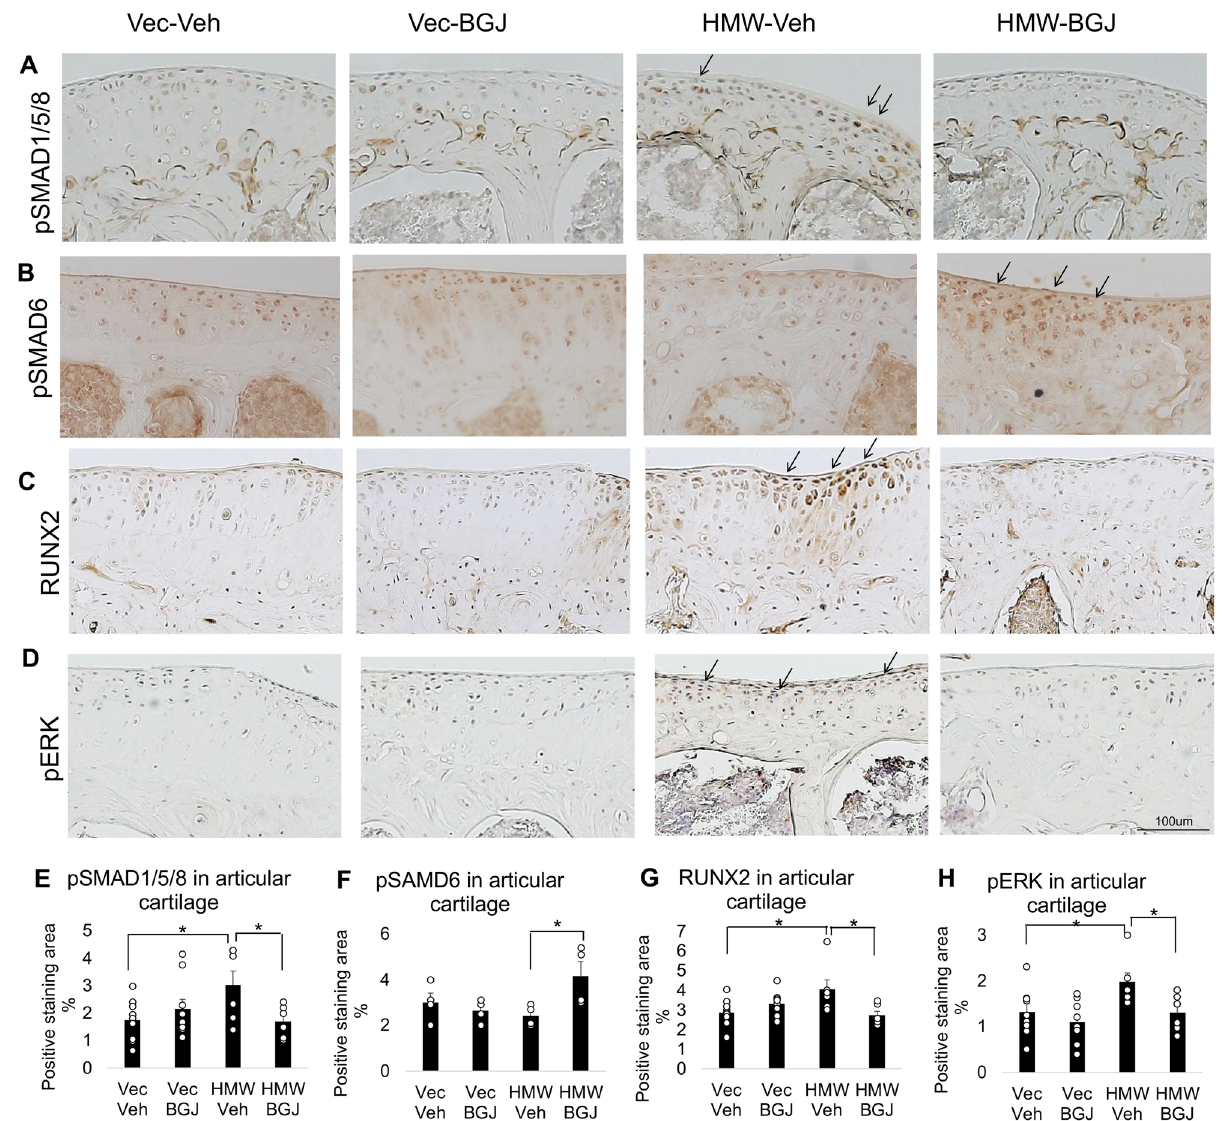
Figure 9. Expression of pSMAD1/5/8, pSMAD6, RUNX2 and pERK in knee articular cartilage of 9.5-month- old Vector-Control and HMWTgFGF2 mice treated with BGJ398. Eight month-old Vector-Control (Vec) and HMWTgFGF2 (HMW) female mice were sq injected with vehicle or BGJ398 5 days/week for 6 weeks. At the end of the experiment (9.5 month old) knee joints were collected for IHC staining. Representative immunohistochemical staining images for ( A ) pSMAD1/5/8, ( B ) pSMAD6, ( C ) RUNX2, and ( D ) pERK. Quantitative analysis of percent-positive staining area for ( E ) pSMAD1/5/8, ( F ) pSMAD6, ( G ) RUNX2, and ( H ) pERK in articular cartilage. Data are shown as mean and individual points. n = 7–9 mice/group for ( E , G , H ); n = 4 mice /group for ( F ). *p < 0.05 by two-way